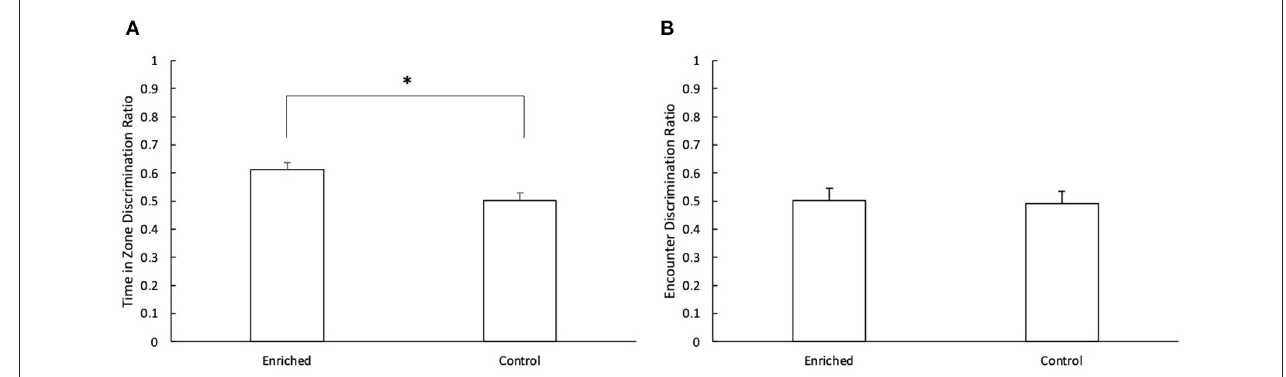
FIGURE 5 | Retention Phase of the NOR. (A) Comparison of the time in zone discrimination ratio for Enriched and Control fish and (B) Comparison of the encounter discrimination ratio for Enriched and Control fish during the retention phase of the NOR. * Denotes significant difference at P < 0.05. Values are displayed as mean ±